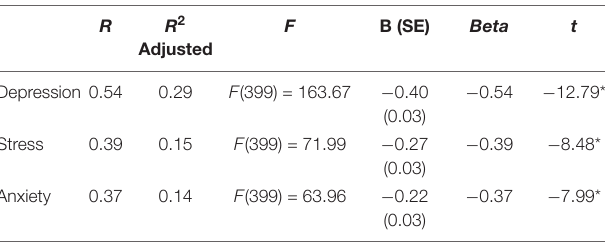
TABLE 3 | Simple linear regression for mental health indicators (social connection as